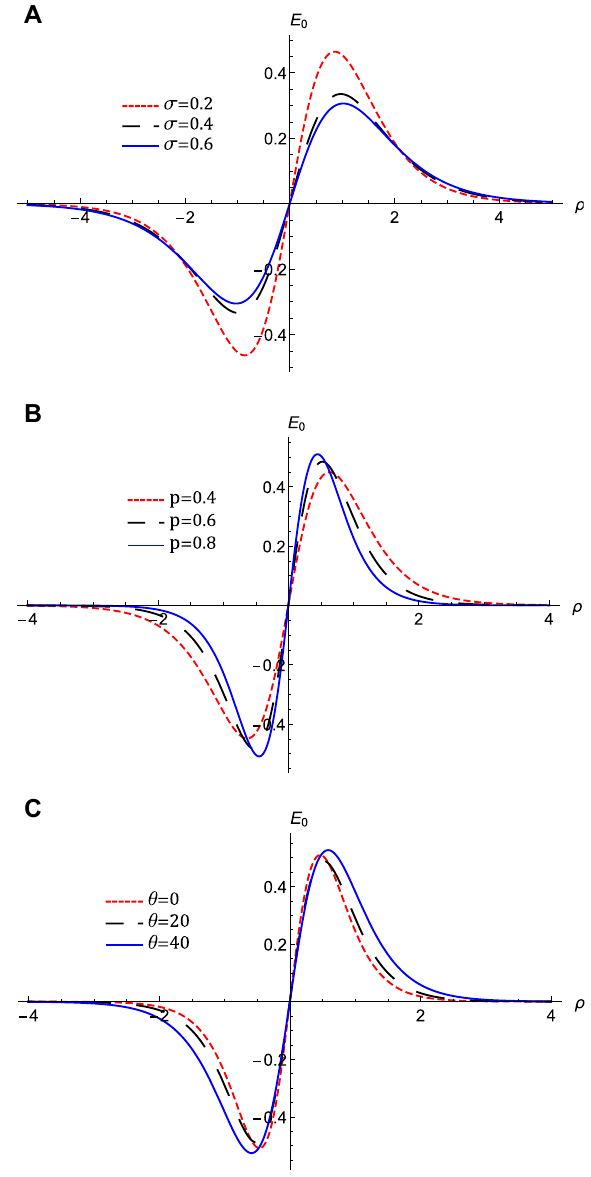
Figure 5. The evolution of the associated electric field, E 0 of QIASWs that represented by equation ( 18 ) with ρ for the potentials those represented by Fig. 5, ( A ) for different values of σ with p = 0.1 , θ = 1 , H e = 0.1 , and H p = 0.6 , ( B ) for different values of p with σ = 0.4 , θ = 1 , H e = 0.1 , and H p = 0.6 , ( C ) for different values of θ with p = 0.7 , σ = 0.4 , H e = 0.1 , and H p = 0.6 , ( D ) for different values of H e with p = 0.7 , σ = 0.4 , θ = 1 , and H p = 0.6 , ( E ) for different values of H p with p = 0.7 , σ = 0.4 , θ = 1 , and H e = 0.6